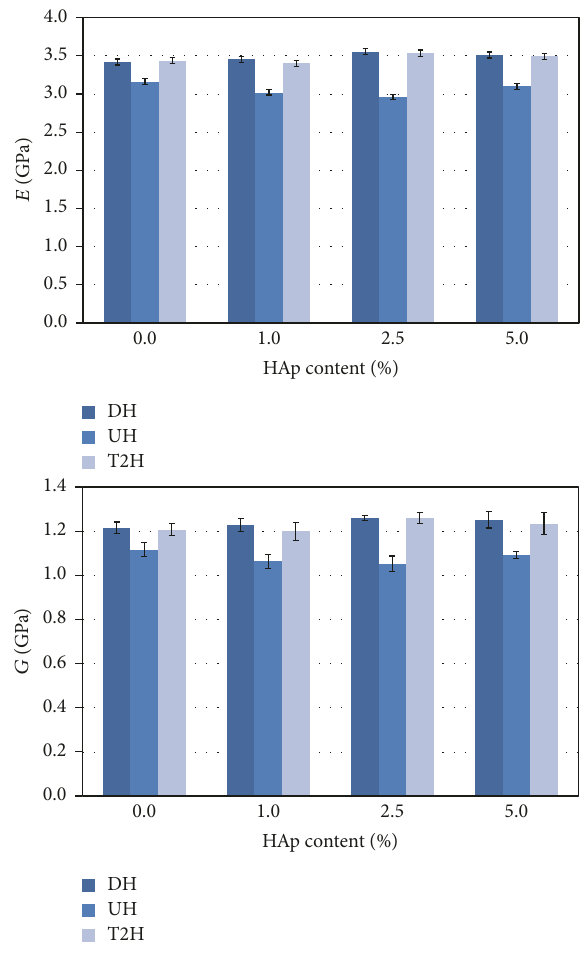
Figure 9: Ultrasonic Young’s modulus 𝐸 [GPa] and Kirchhoff’s modulus 𝐺 [GPa] calculated based on measurements of ultrasound velocities. Error bars represent standard